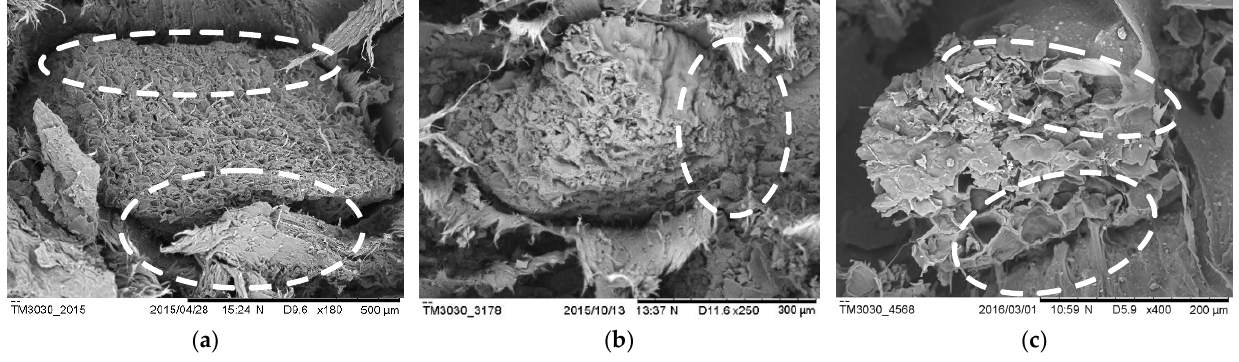
Figure 10. SEM micrograph of GCW particles of ( a ) UG, ( b ) OG and ( c ) ONG.